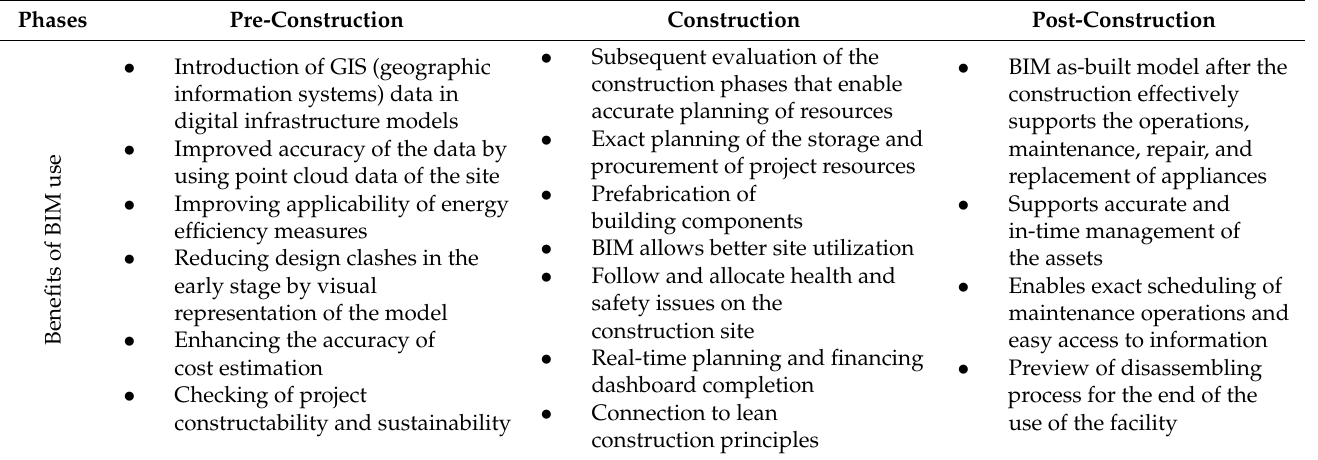
Table 1. Benefits of BIM adoption.